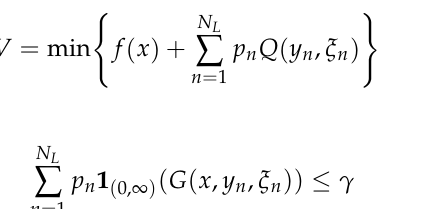
Algorithm 1 outlines the main steps of the SAA algorithm combined K-means